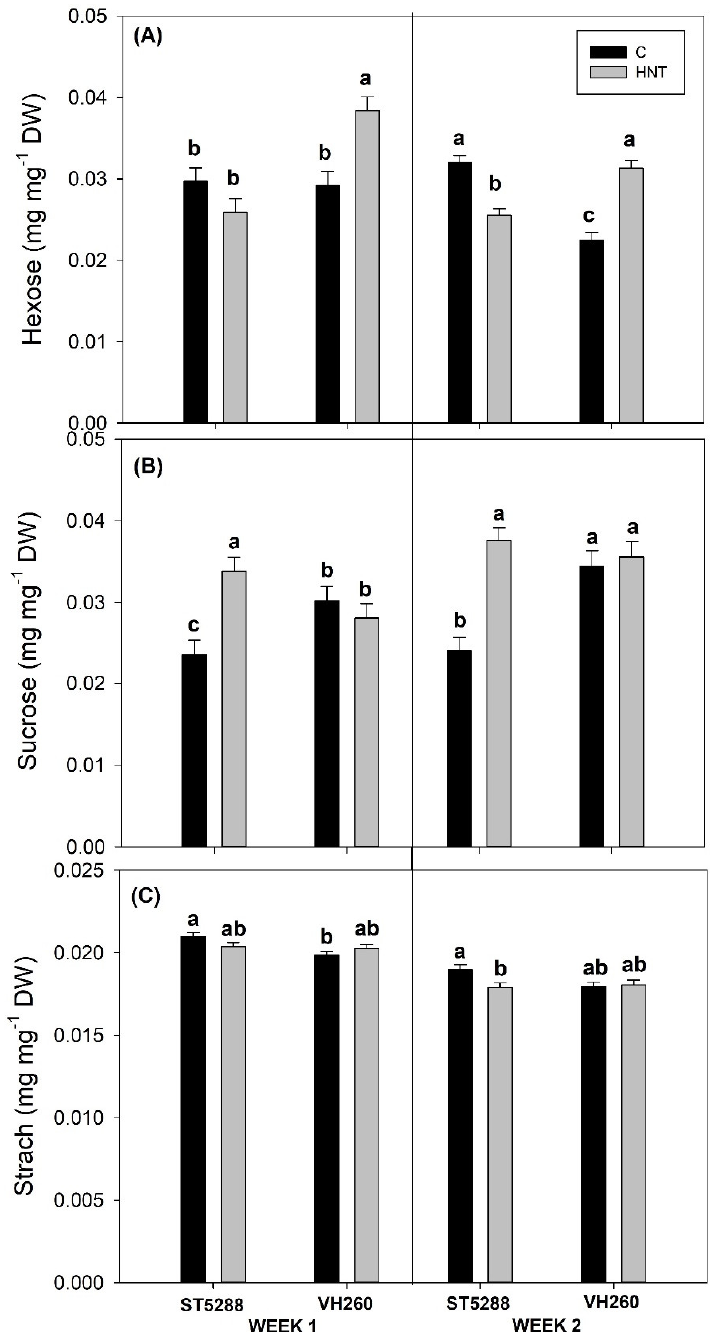
Figure 5. Effect of high night temperatures on pistil hexose ( A ), sucrose ( B ), and starch ( C ) content at the end of the first and second week after initiation of the treatment. Columns connected with different letters are significantly different ( p = 0.05). Error bars represent ±1 standard error. (C: control temperatures 32/24 °C, HNT: high night temperatures 32/30 °C).